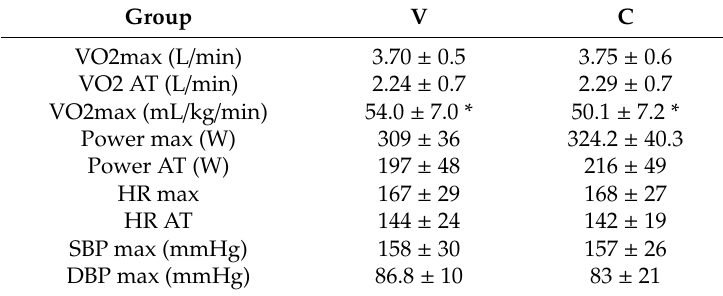
Table 2. Performance parameters.